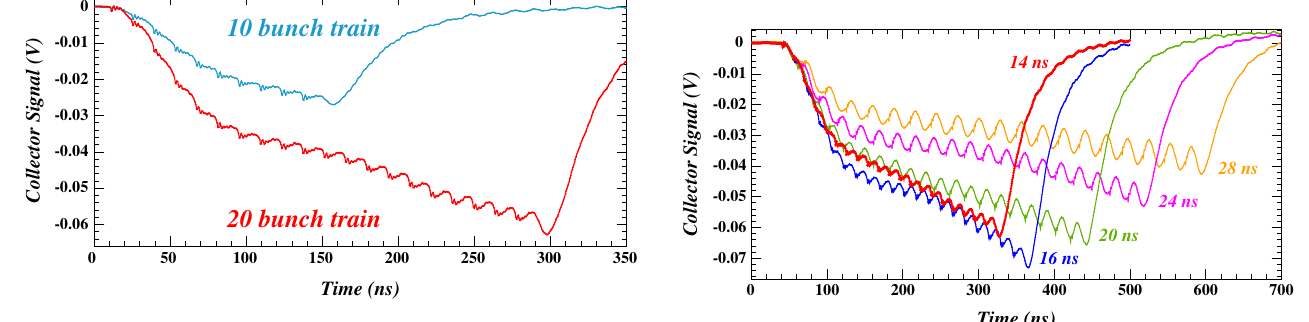
FIG. 5. Comparison of signals obtained from 20-bunch trains with spacing 14, 16, 20, 24 and 28 ns. The increase in signal for the 16-ns spacing relative to the 14-ns spacing shows that long- term cloud electron trapping can be enhanced by an unfortunate choice of bunch